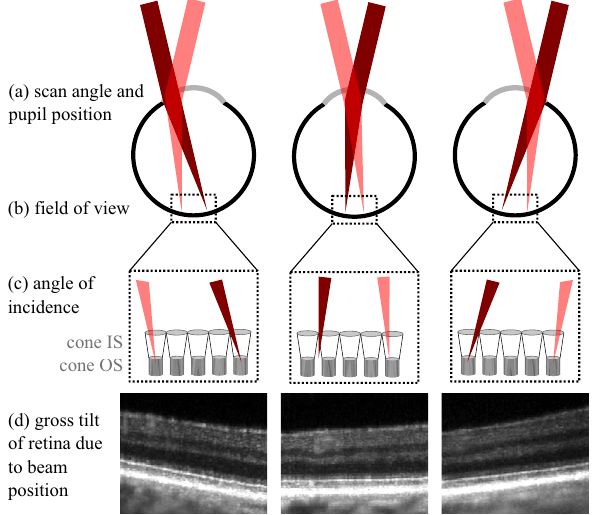
Figure 1. Concept of directional OCT. ( a ) To measure direction-dependent changes in the OCT image, the scanning beam is moved across the pupil. The light red and dark red beams represent the extremes of the scan angle. The pupil of the eye is optically conjugated with the galvo scanners, and, thus, the beam does not move in the pupil while scanning. ( b ) Notwithstanding eye movements, the portion of retina scanned is constant with respect to the beam’s position in the pupil. ( c ) The angle with which the beam illuminates the retina, however, changes as the beam is moved in the pupil. Additional angular differences may arise over the course of the scan if the scanner/pupil plane is displaced from the eye’s optical center. ( d ) When the beam is moved in the pupil, the OCT B-scan appears to tilt due to scan-angle-dependent variation in the beam’s path